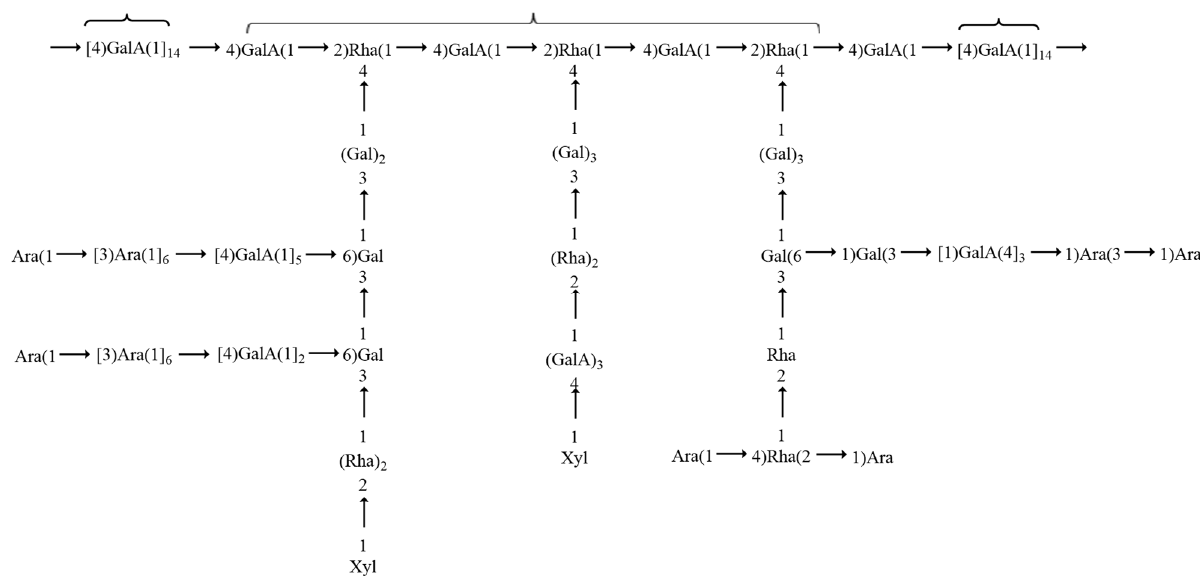
Figure 3. The hypothetical structure of the repeat unit of the glycan of LRGP5.